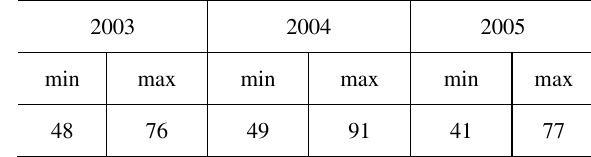
Table 2. Extreme values of radionuclide 137 Cs VA (Bq/m 3 )